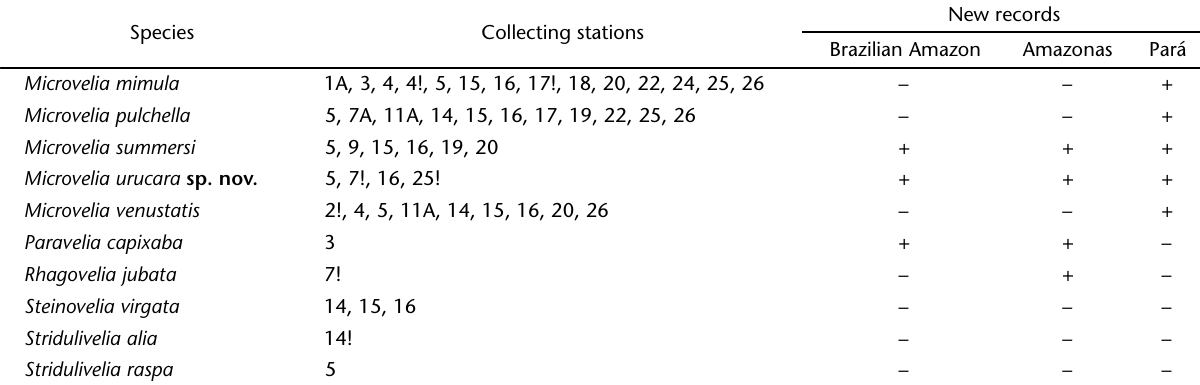
Table II. Distribution of the Veliidae collected along the Amazon River floodplain, Brazil. Material collected on streams or lakes near the main sampling sites are marked by an exclamation mark. New records are displayed by “+” sign on the last three columns.